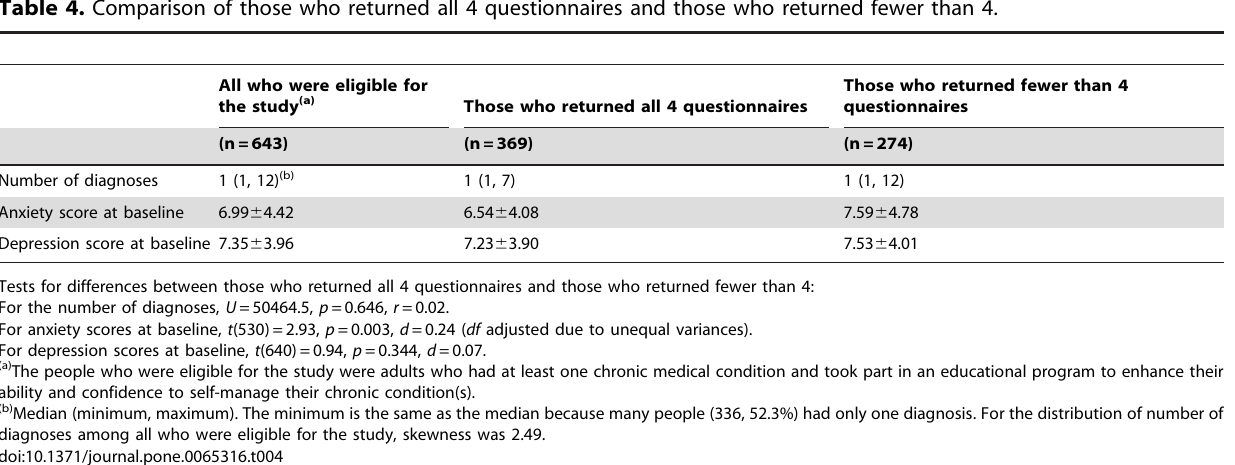
Table 4. Comparison of those who returned all 4 questionnaires and those who returned fewer than 4.